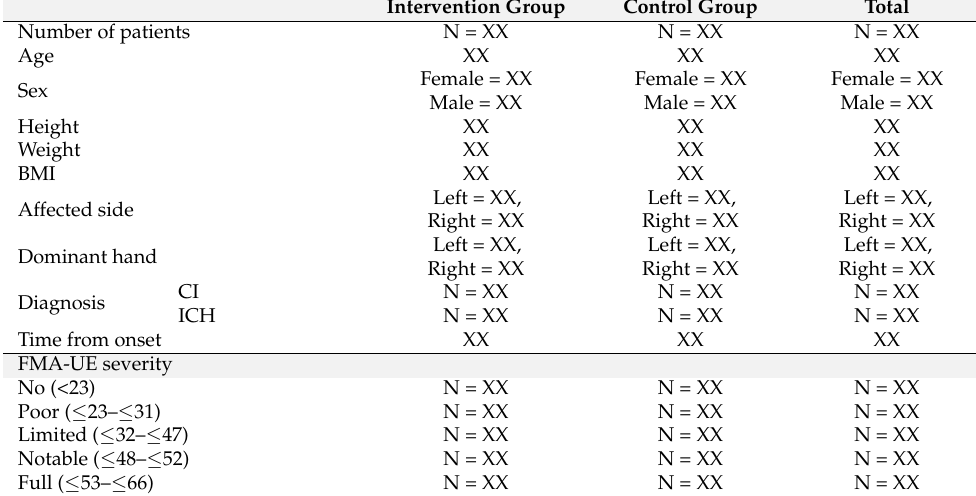
Table 1. Demographic data of